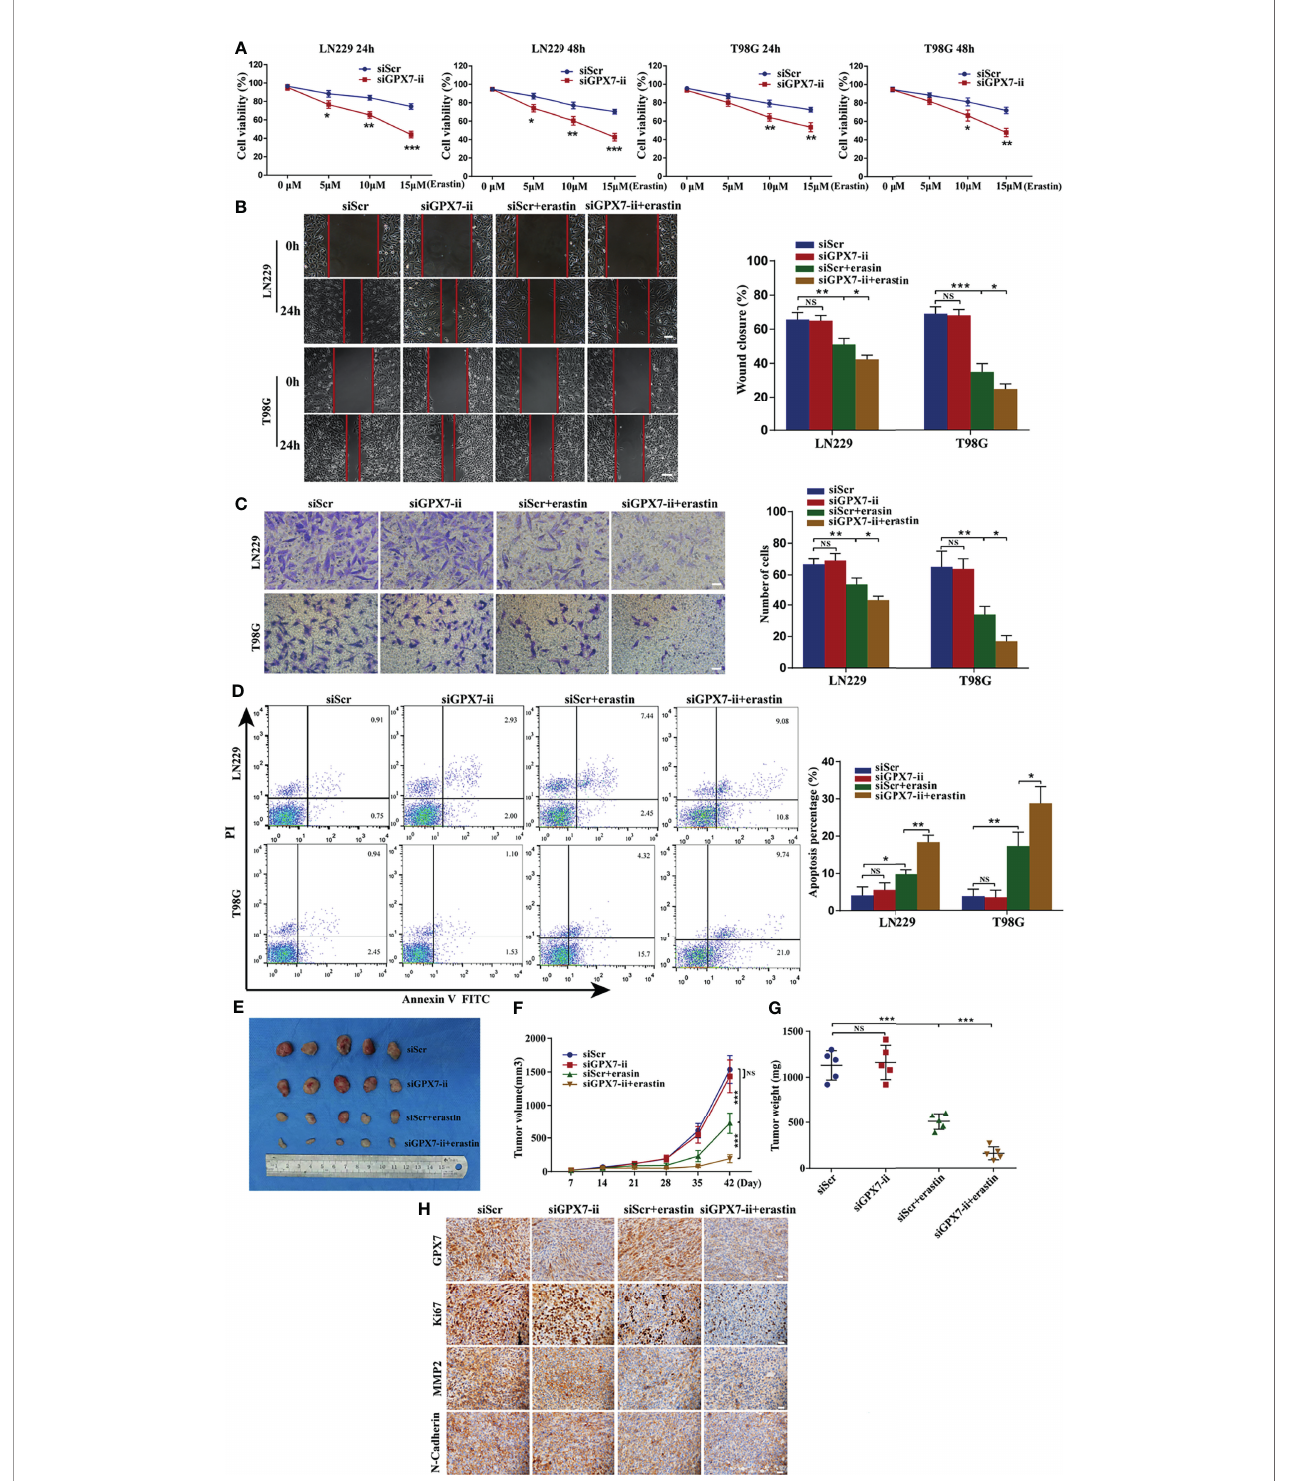
FIGURE 5 | GPX7 silencing sensitizes glioma cells to erastin both in vitro and in vivo . (A) CCK-8 assay was applied to analyze the viability of LN229 and T98G cells treated with different concentrations of erastin following the transfection with siGPX7 and siScr. (B) Migration ability of cells was analyzed using wound-healing assay. Scale bar, 250 m m. (C) Invasive ability of cells was evaluated by transwell assay. Scale bar, 100 m m. (D) FITC annexin V and PI apoptosis assay. (E) Knockdown of GPX7 enhanced erastin-induced ferroptosis in vivo . The volume of tumors was shown (F) , and the tumor weight was measured at the endpoint (G) . (H) Immunohistochemistry staining of xenograft model-derived tumors for GPX7, Ki67, MMP2 and N-Cadherin. Scale bar = 100 m m. *P < 0.05, **P < 0.01, ***P < 0.001. ns, not signi fi